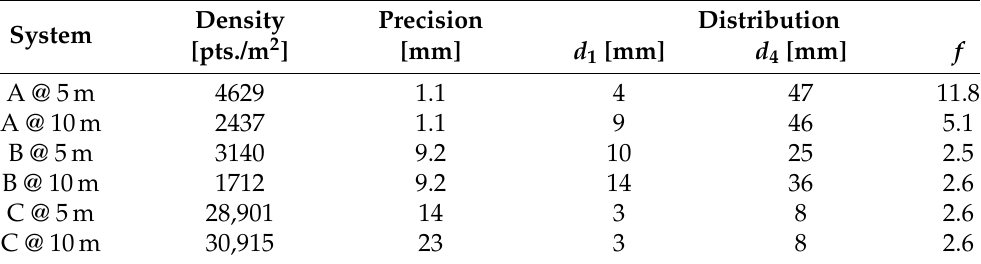
Table 2. Performance parameters of point cloud quality at the test chart parallel to the trajectory in a distance of 5m and 10m. The @-Symbol denotes that for a certain mobile mapping system the data acquired at a certain distance is